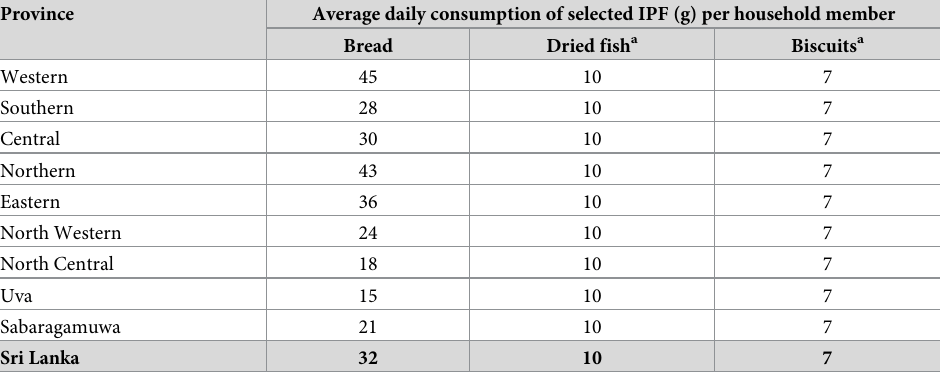
a Provincial intake estimates based on the national estimate in the absence of province-specific data for these